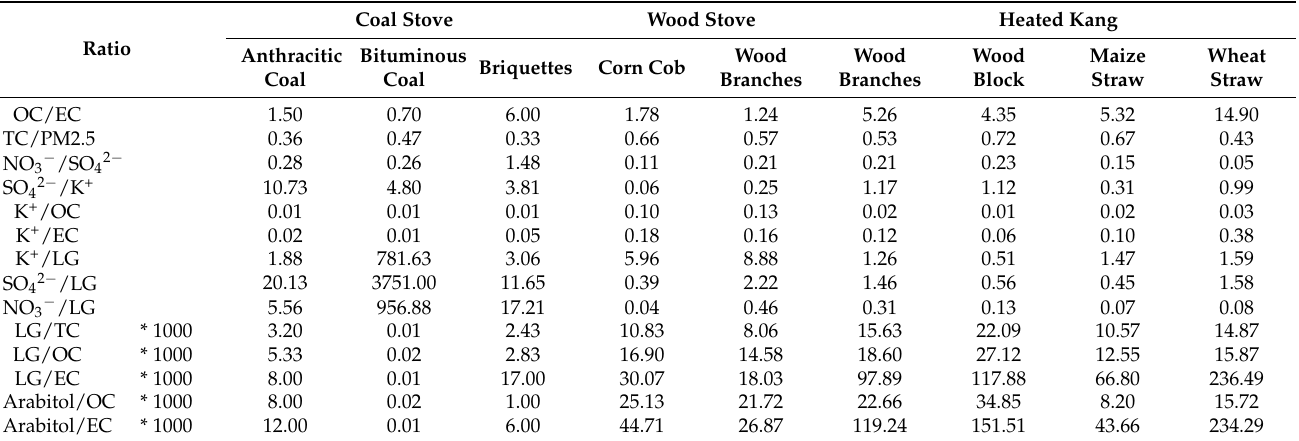
Table 4. The ratio of specific components for coal and biomass